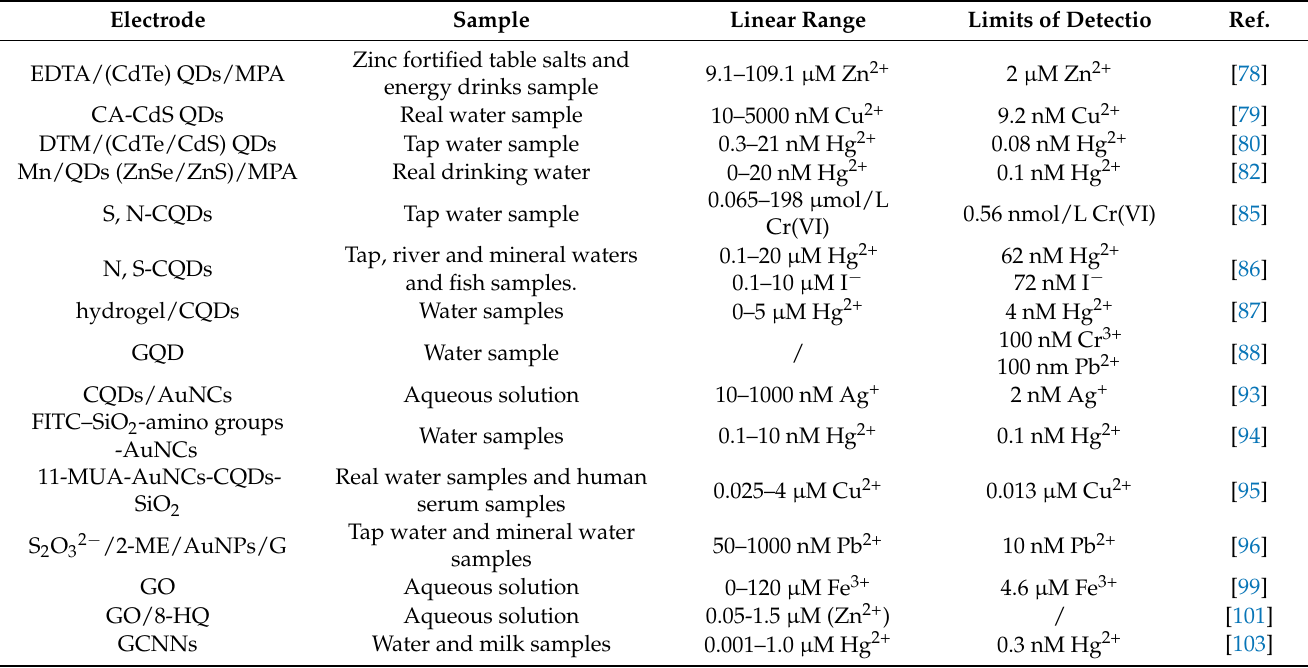
Table 4. Representative studies of fluorescent analysis of heavy metals from food and water resources by nanofluorophores and